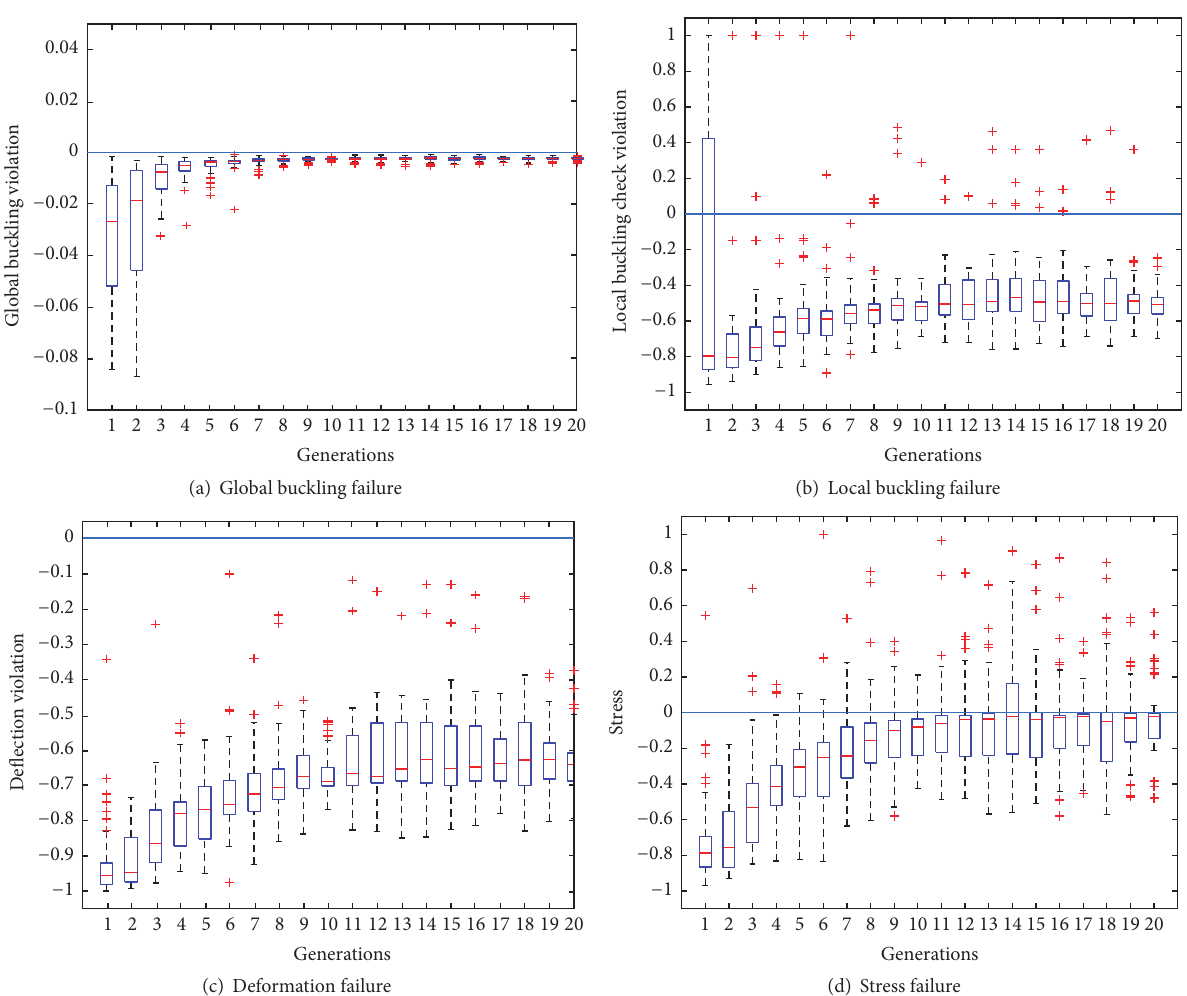
Figure 7: These figures show that global buckling is not an important constraint while the stress constraint is the most important one. The optimisation tries therefore to stay on the edge of the stress